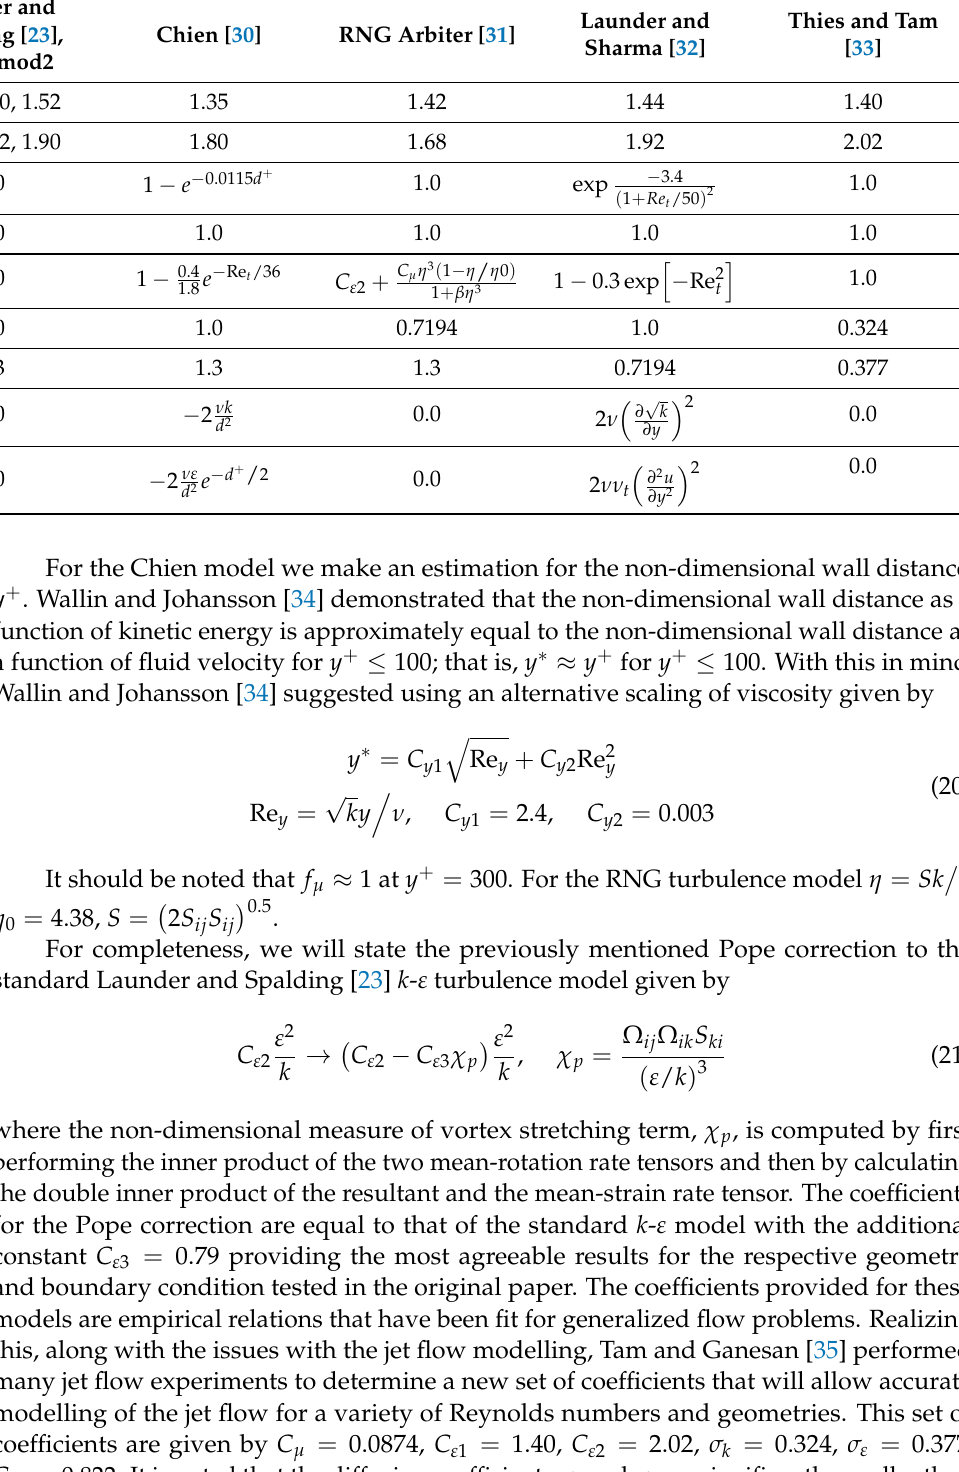
Table 2. k - ε turbulence models that are used in the present study. Re t = k 2